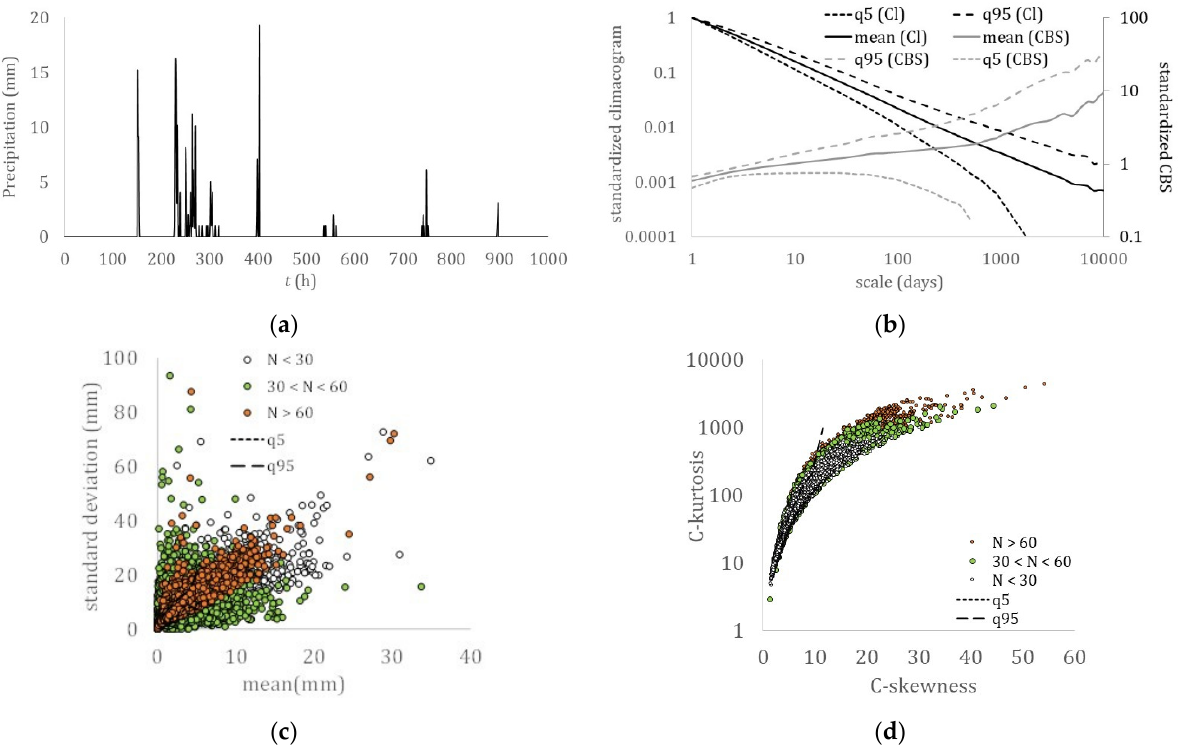
Figure 8. Precipitation: ( a ) hourly sample (Potomac River, USA); ( b ) climacogram and climacospectrum (mean, and 5% and 95% quantiles); ( c ) mean vs. standard deviation; ( d ) C-skewness vs. C-kurtosis.